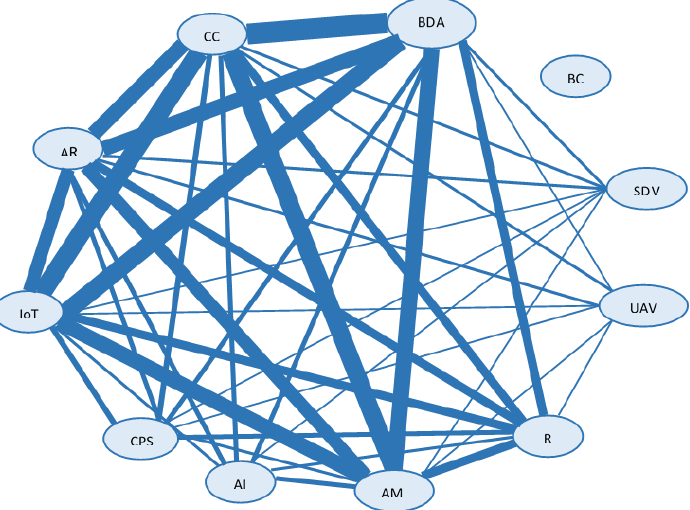
Figure 8. Assessing combinations of technologies in Lean DSC .